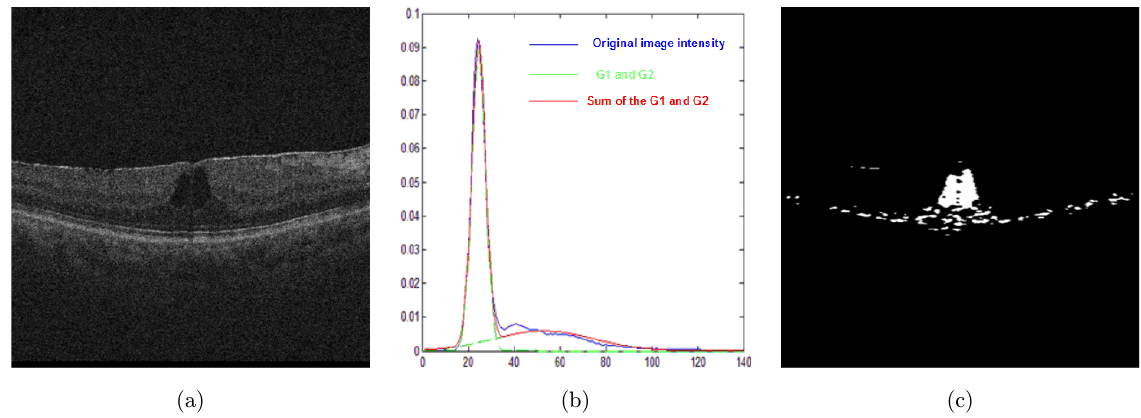
Fig. 3. (a) Original image, (b) The distribution histogram of image intensities. The lateral axis stands for the intensity value. The vertical axis stands for the probability of each intensity. The blue curve stands for the intensity distribution of original whole image. The two green curves represent Gaussian distribution G1 and G2, respectively. G1 and G2 represent the Gaussian function with di®erent mean values, respectively. The red curve is the sum of G1 and G2 and (c) The result map of GMM clustering with region